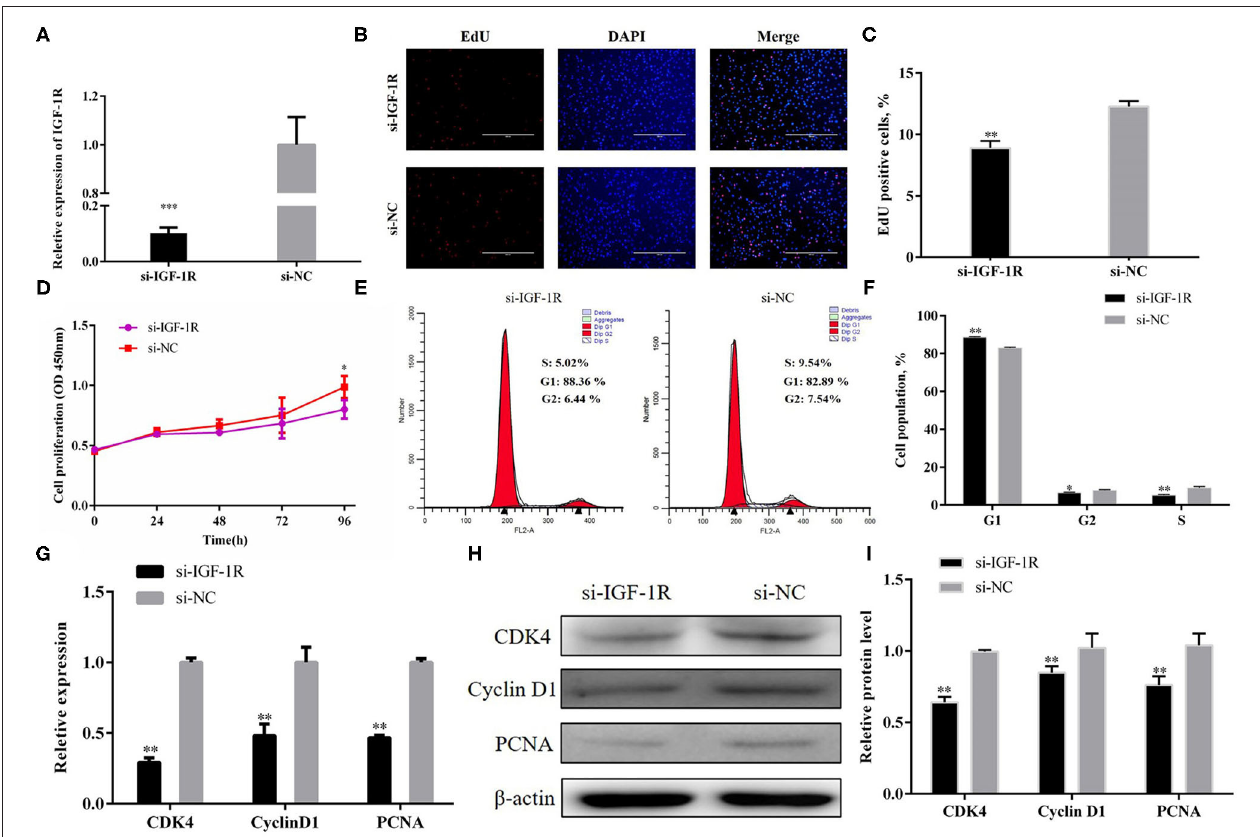
FIGURE 6 | IGF-1R facilitated PSC proliferation. (A) Transfection efficiency of si-IGF-1R. (B) EdU staining after the transfection of si-IGF-1R in PSCs. (C) Statistical results of EdU staining. (D) CCK-8 assay after the transfection of si-IGF-1R into PSCs. (E) Flow cytometry raw data of the cell cycle analysis of PSCs after IGF-1R knockdown. (F) Statistical results of cell cycle analysis. (G) MRNA expression levels of cell cycle marker genes. (H,I) Protein levels of cell cycle marker genes. Results are shown as mean ± SEM, and the data are representative of at least three independent assays. Independent sample t -test was used to analyze the statistical differences between groups (* P < 0.05; ** P < 0.01, and *** P <